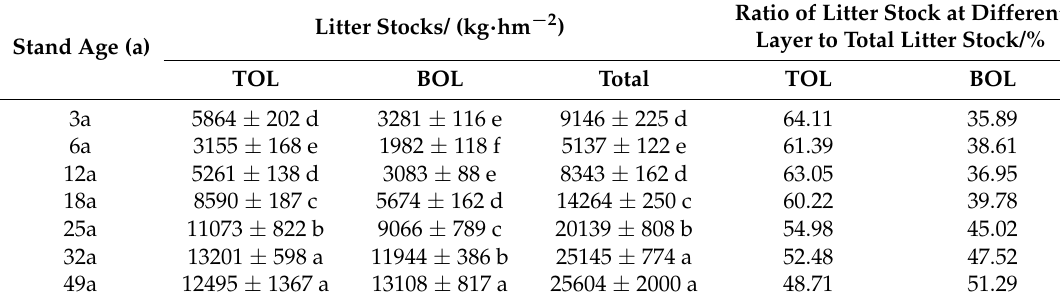
Table 2. Standing litter stocks in the different age